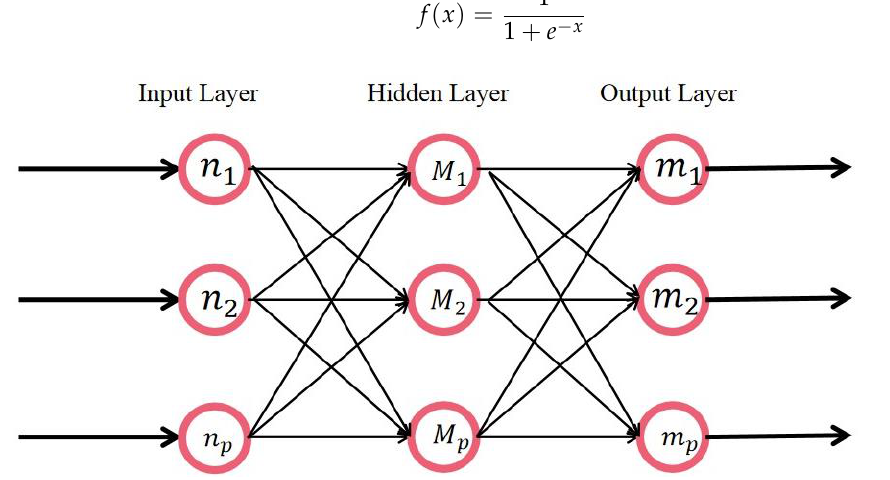
Figure 3. Structure of BP_NN.